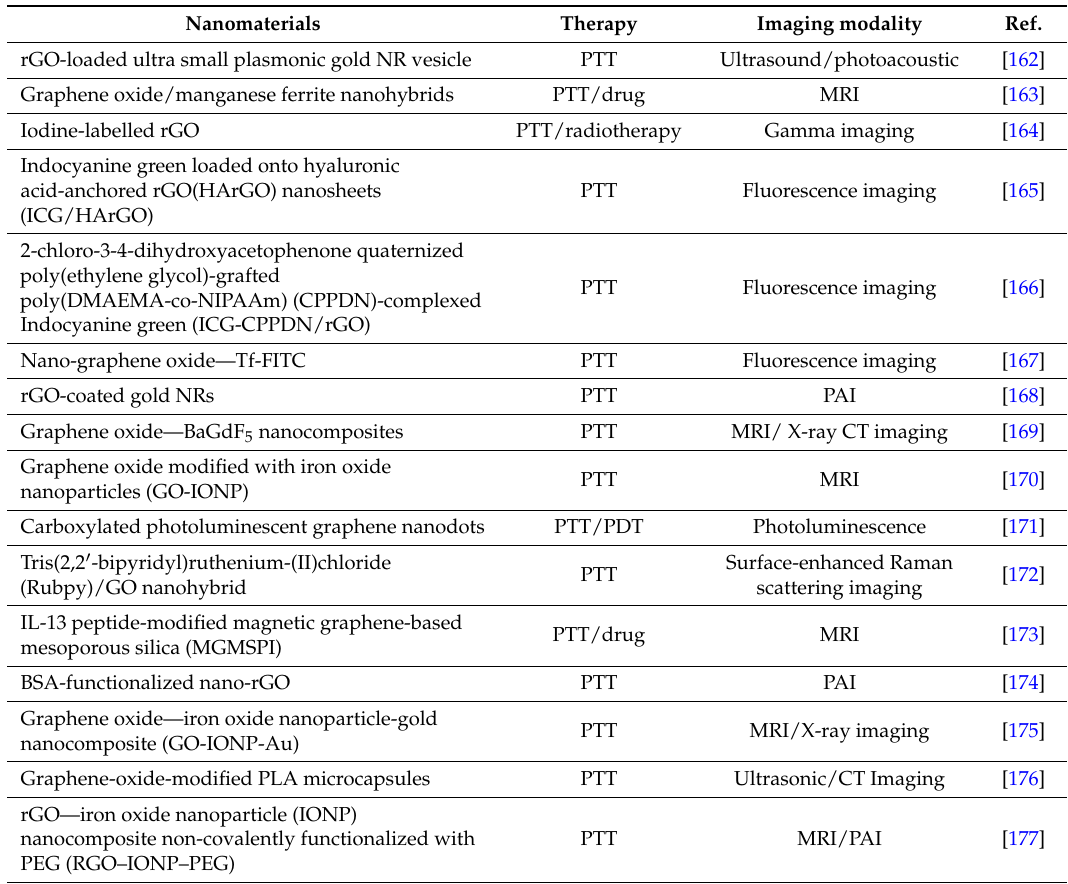
Table 3. Graphene nanoparticles in cancer